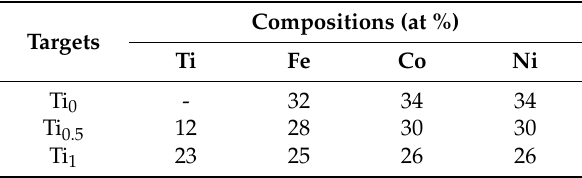
Table 1. Chemical compositions of the Ti x FeCoNi targets analyzed by SEM/EDS Compositions (at %) Targets Ti